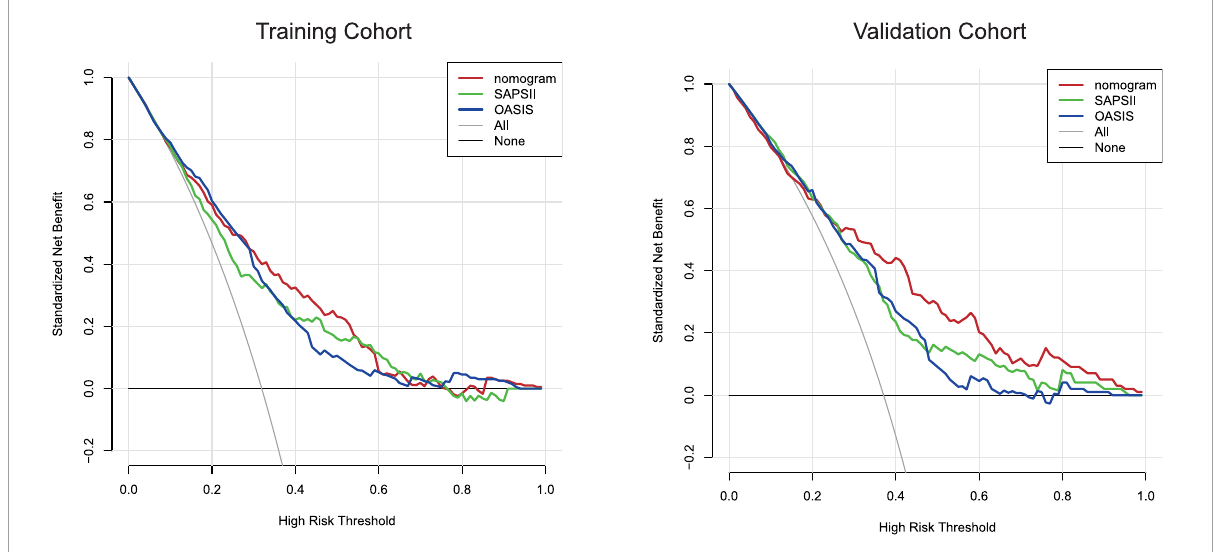
FIGURE6 Decision-curve analysis of the training cohort and the validation cohort. Decision curve analysis depicts the clinical net benefit in pairwise comparisons across the different models. The red line indicates the nomogram, which is the model we built. The green line indicates SAPSII scoring system and the blue line indicates OASIS. Nomogram showed superior net benefit with a wider range of threshold probabilities compared with SAPSII and OASIS.